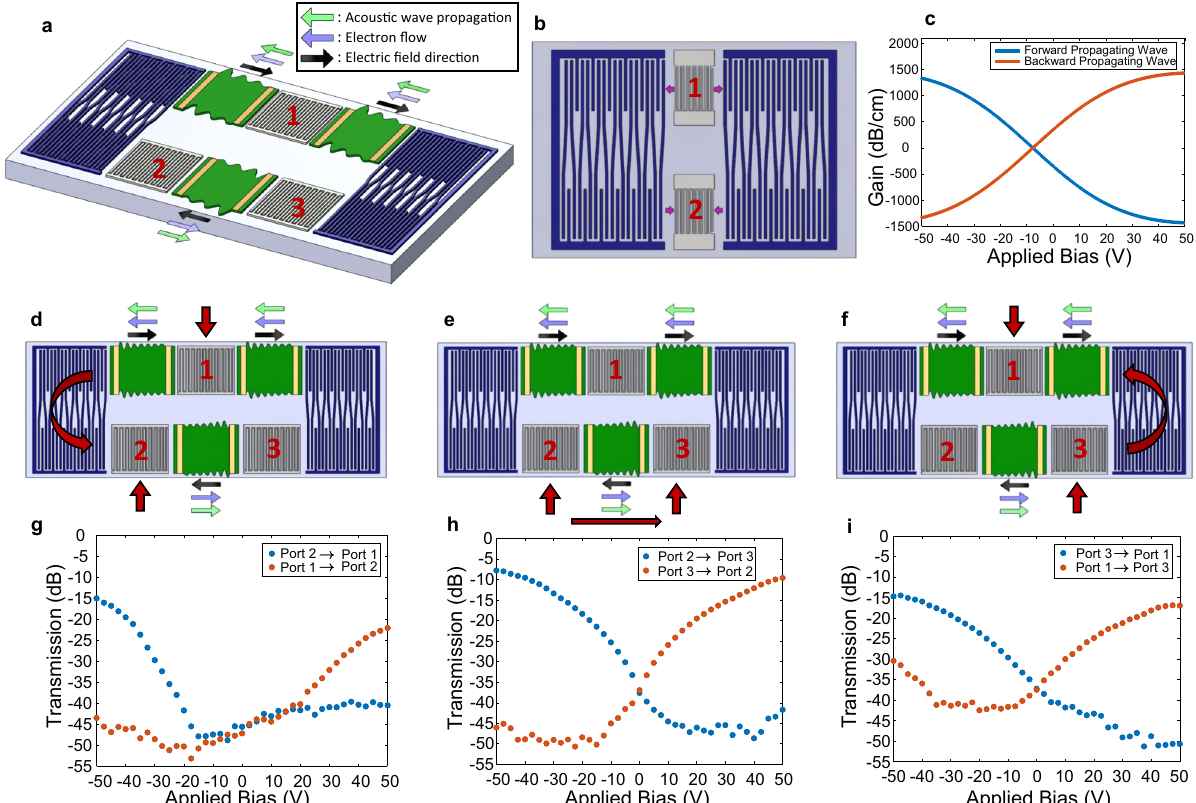
Fig. 5 Acoustoelectric circulator. Schematics of the ( a ) three-port acoustoelectric circulator and ( b ) two-port ring fi lter that is the baseline for the device design. The In 0.53 Ga 0.47 As is shown in green, the LiNbO 3 substrate in light gray, the RF IDTs in dark gray, the DC contacts in gold, and the couplers in purple. The light green, light purple, and black arrows denote the directions for the acoustic wave propagation, electron fl ow, and electric fi eld direction, respectively, for the counterclockwise helicity. c Theoretical nonreciprocal gain as a function of applied bias for each acoustoelectric section. Schematics of the measurements done from ( d ) port 1 to port 2, ( e ) port 2 to port 3, and ( f ) port 3 to port 1 with the corresponding experimental data of acoustic transmission as a function of an applied pulsed DC bias shown in ( g ), ( h ), and ( i ), respectively. The acoustic transmission is measured by detecting a change in the S-parameters with respect to time during a continuous RF input at 276 MHz and the application of a 1 ms voltage pulse. A measurement is made every 50 ms giving a duty cycle of